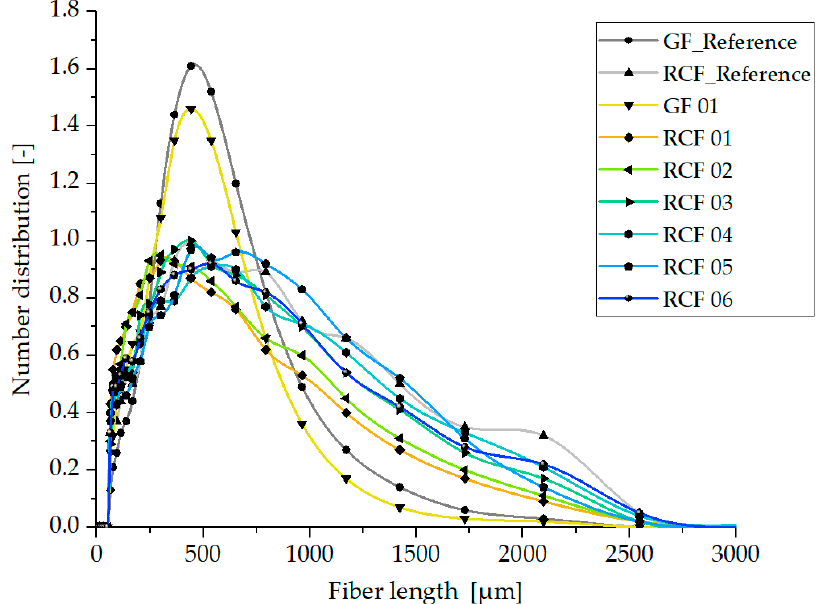
Figure 7. Fiber length distribution in specimen produced with the open hot runner system.